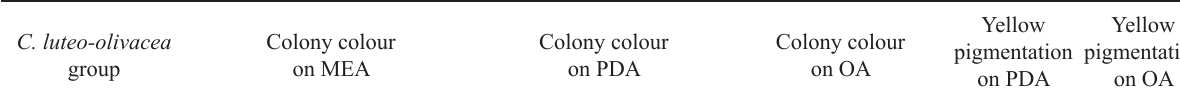
Colony colour on PDA